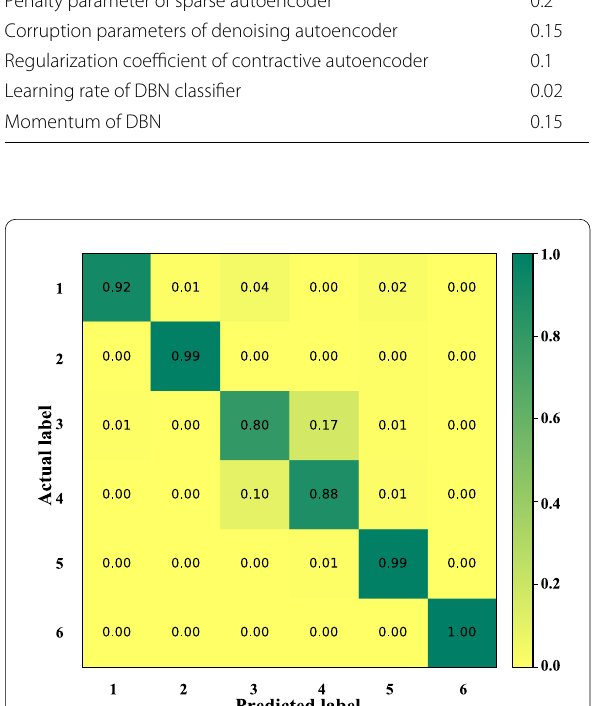
Figure 11 Multi-class confusion matrix for the first experiment on the proposed